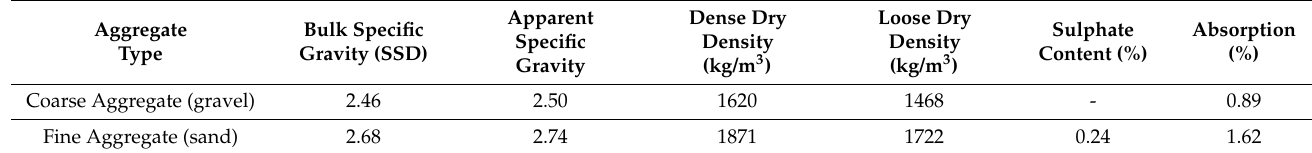
Table 3. Physical properties of aggregate.